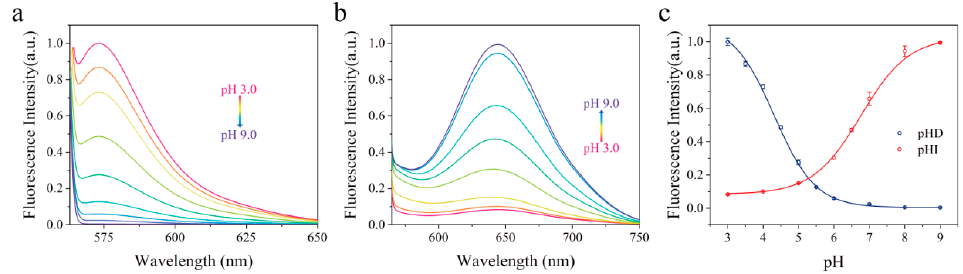
Figure 3. Normalized fluorescence emission spectra of ( a ) pHD and ( b ) pHI in BR buffer solution at different pHs. ( c ) pH − dependent emission intensity of pHD at 575 nm and pHI at 650 nm.